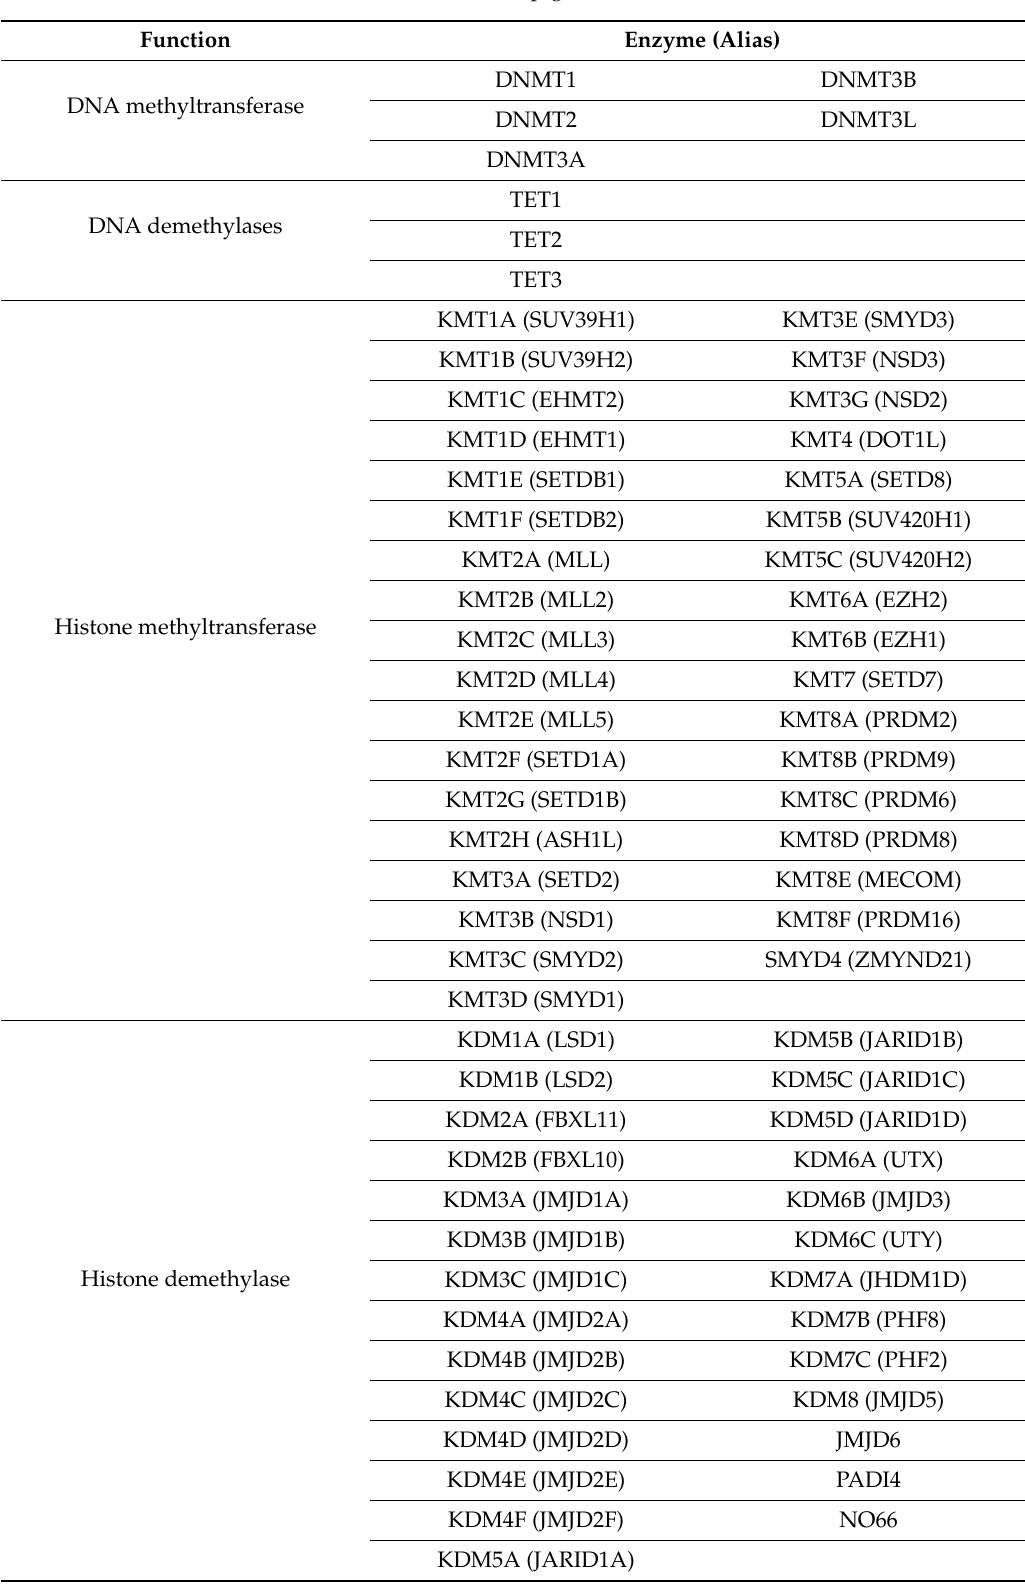
Table 1. Mammalian epigenetic